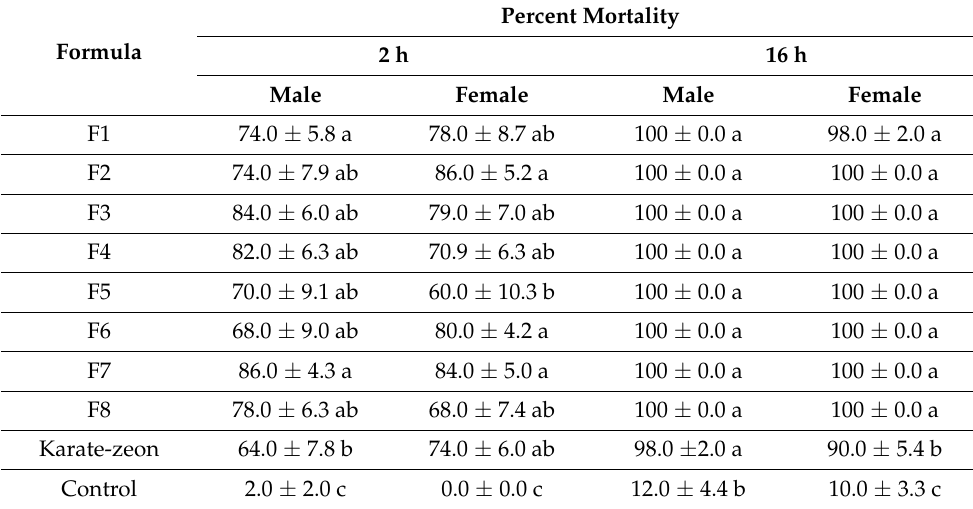
Table 4. Percent mortality ( ± standard deviation) of male and female D. suzukii exposed to residual strawberries treated with CS-LC nanoparticles. Means within each column (time-gender) followed by the same letter (s) are not significantly different (Tukey’s LSD test; p = 0.05).